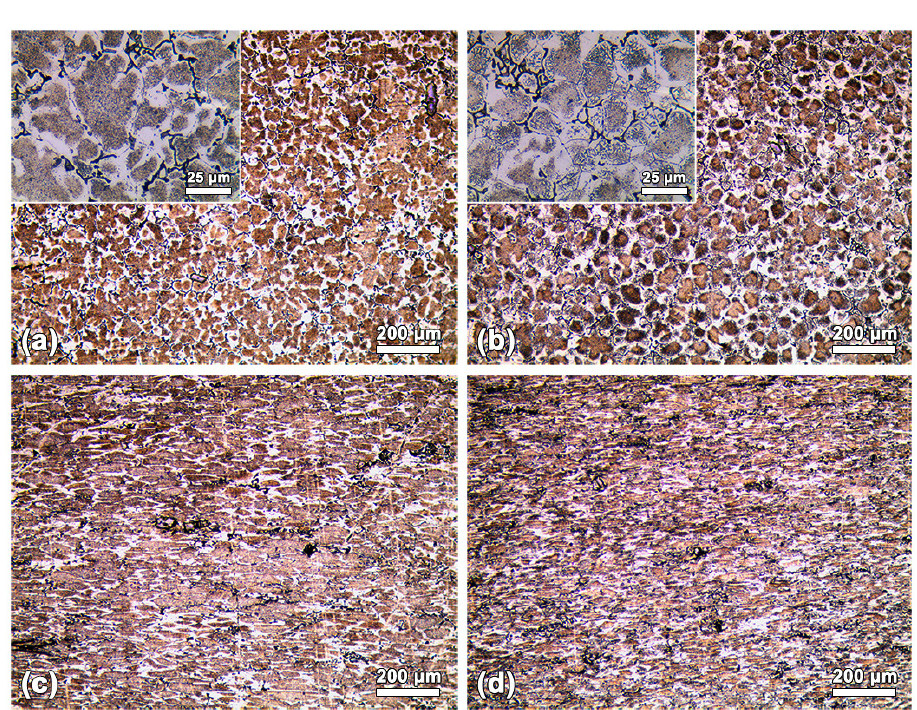
Figure 3. Typical OM images recorded from ( a ) sample A (Sc-free and non-hot-rolled), ( b ) sample B (Sc-microalloyed and non-hot-rolled), ( c ) sample A’ (Sc-free and hot-rolled), and ( d ) sample B’ B (Sc-microalloyed and non-hot-rolled), ( c ) sample A (cid:48) (Sc-free and hot-rolled), and ( d ) sample B (cid:48) (Sc-microalloyed and hot-rolled). (Sc-microalloyed and